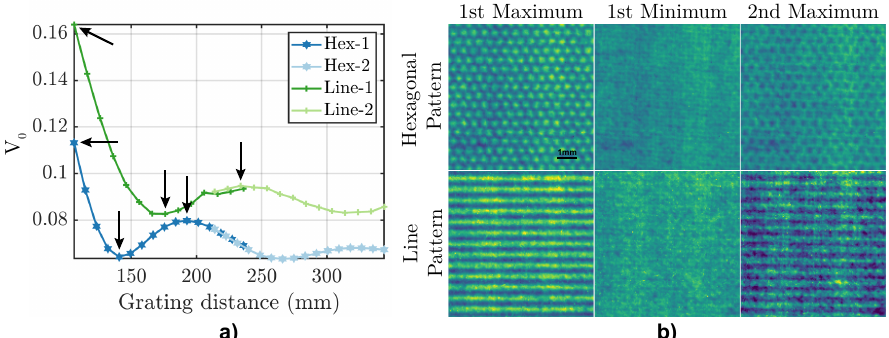
Figure 2. ( a ) Modulation of the grating visibility as a function of the distance between the grating and the neutron detector. The green lines with cross markers correspond to the line pattern grating whereas the blue lines with star markers correspond to the hexagonal 2D pattern grating. The dark and light lines indicate two separate grating distance scans acquired at two different manually fixed positions on an optical bench of the motorized grating linear stage. ( b ) Projections of the hexagonal and line pattern gratings obtained at the grating distances indicated with the black arrows in ( a